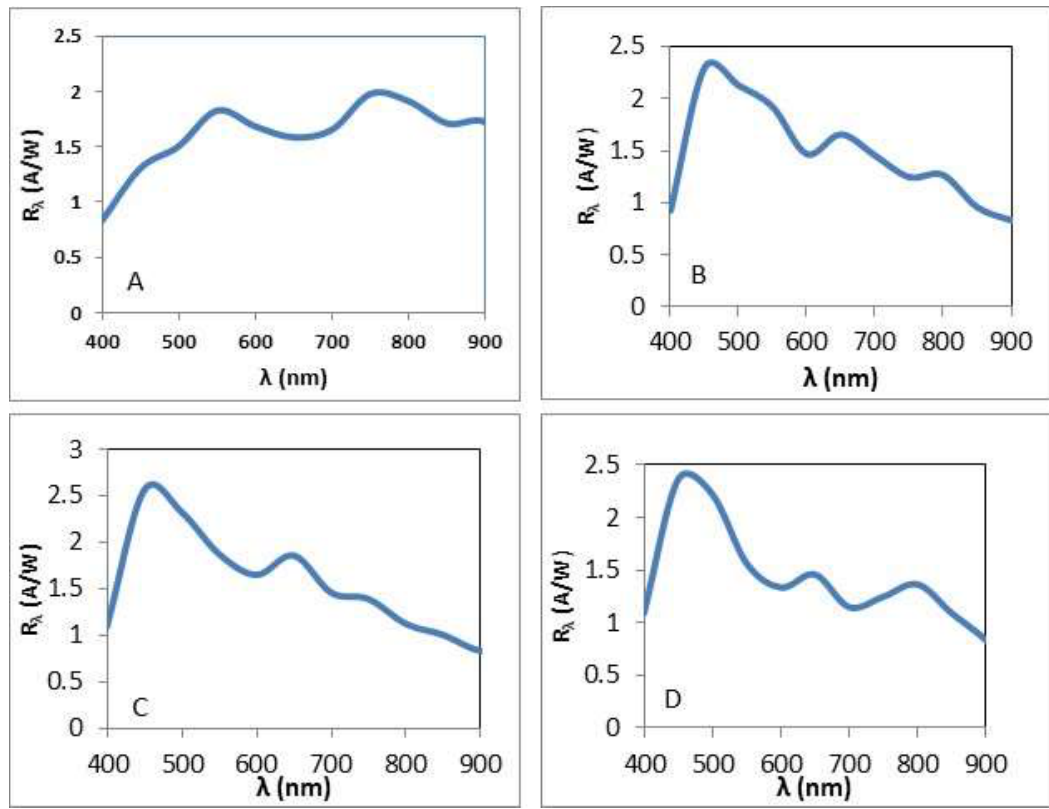
Figure 6: Responsivity of (A) PS and Au: TiO 2 NPs/PS samples at different laser energy ablated (B) 600, (C) 800 and (D) 1000 mJ, 100 pulses with laser wavelength 1064